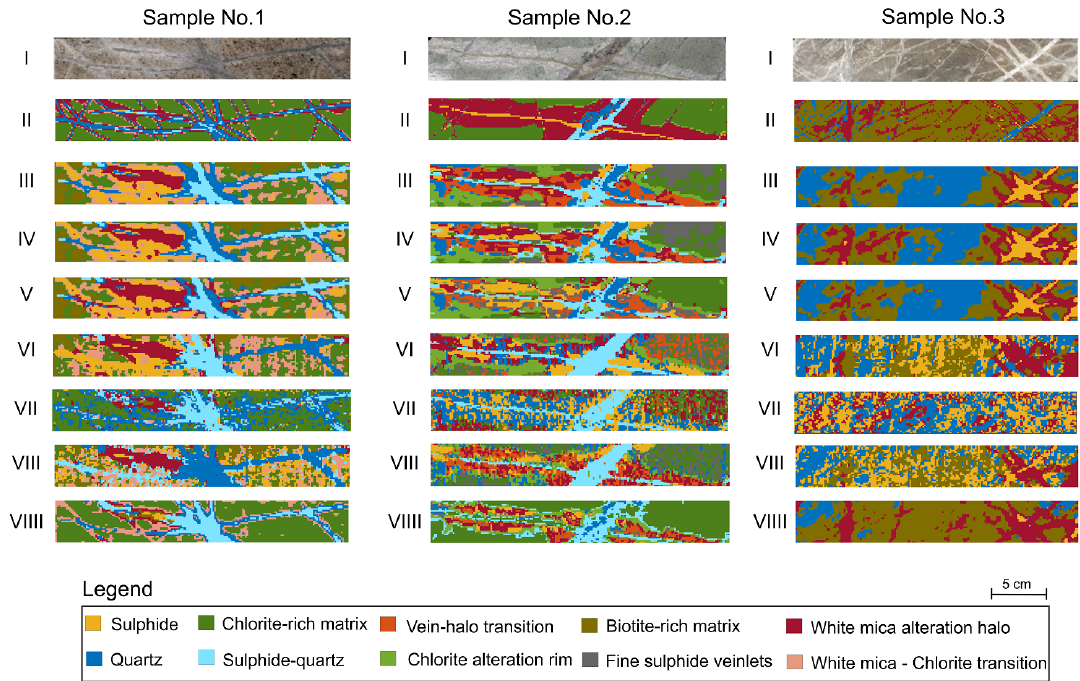
Figure 5. Clustering maps of three investigated samples using a fixed number of clusters. Sample No. 1, Sample No. 2, and Sample No. 3 contain 7, 8, and 4 clusters, respectively. (I) RGB image of the drill-cores; (II) a manually generated mineral reference resized to the pixel size of the hyperspectral image, and the clustering results obtained by (III) K-means; (IV) FCM; (V) ECC; (VI) SSC; (VII) SSC-OMP; (VIII) ESC; and (VIIII) the proposed algorithm.